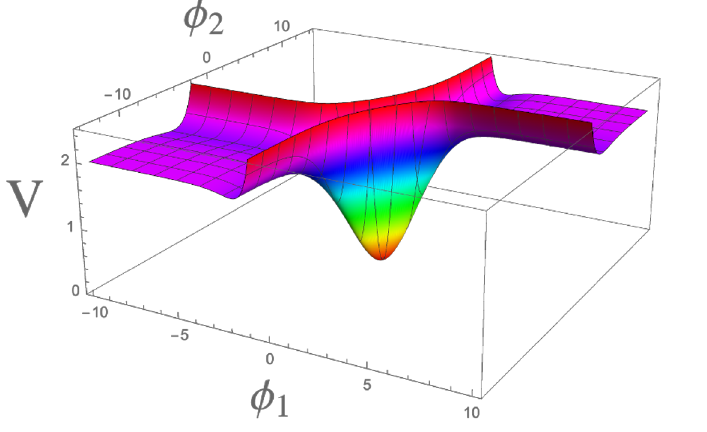
Figure 15 . The potential V infl of the T-model with flat directions φ 1 and φ 2 , with 3 α 1 = 1 and 3 α 2 = 6 .